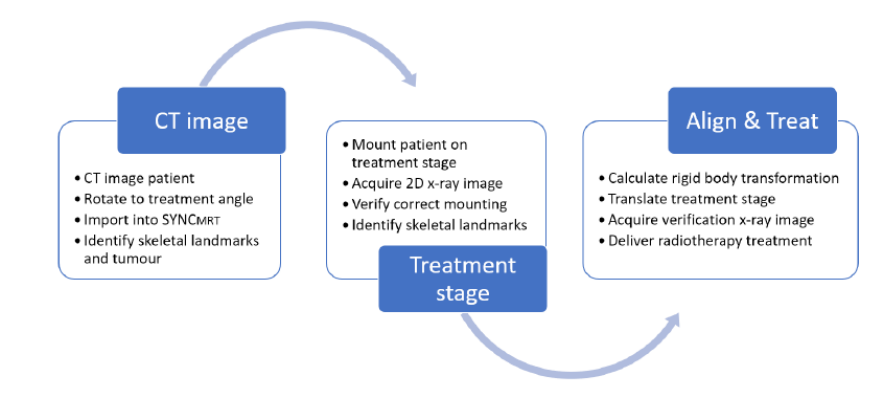
Figure 3. A brief overview of the entire treatment workflow, following patients from CT imaging through to